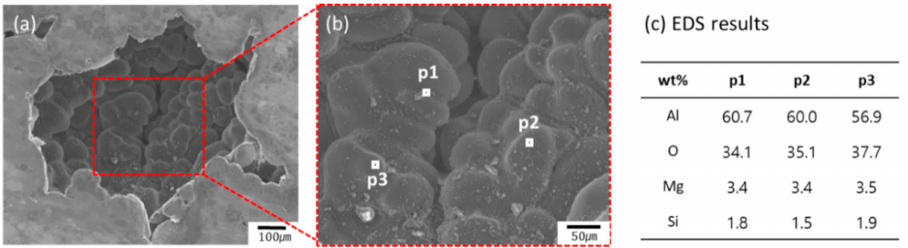
Figure 5. Bifilm index ( a ) and number and average length of bifilms ( b ) measured in reduced-pressure samples of Al-Mg alloys with di ff erent Mg contents.